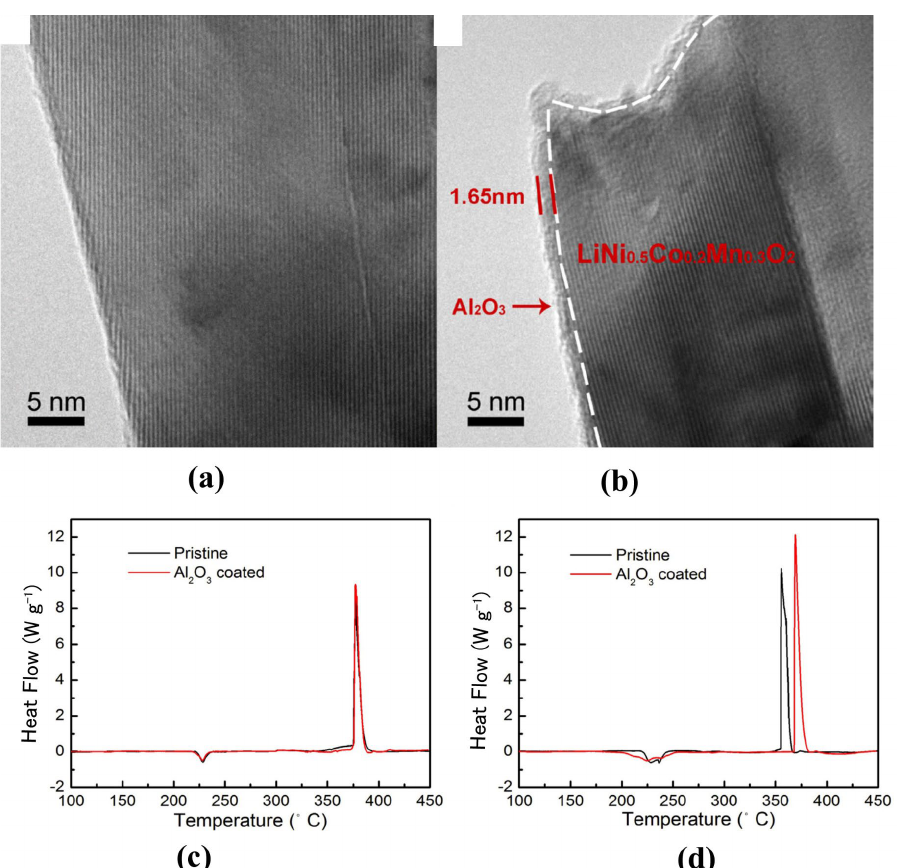
Figure 5. HRTEM images of NCM523 particles before ( a ) and after ( b ) Al 2 O 3 ALD coatings, and DSC curves of the sealed pan with pristine or Al 2 O 3 coated electrode material and electrolyte ( c ) 1st charged to 4.8 V and ( d ) Charged to 4.8 V after 20 cycles [83].